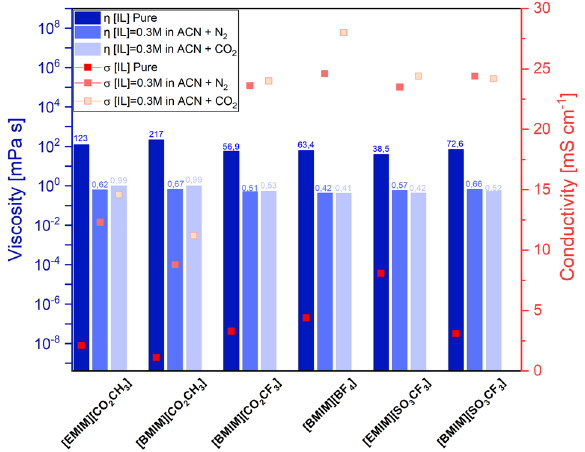
Fig. 1 Conductivity and viscosity properties of the ILs-based electrolytes. Comparison between pure ionic liquids and their solutions in acetonitrile both in N 2 and CO 2 saturated atmosphere. Conductivity and viscosity results were reported in red scatter and blue bar graphs,